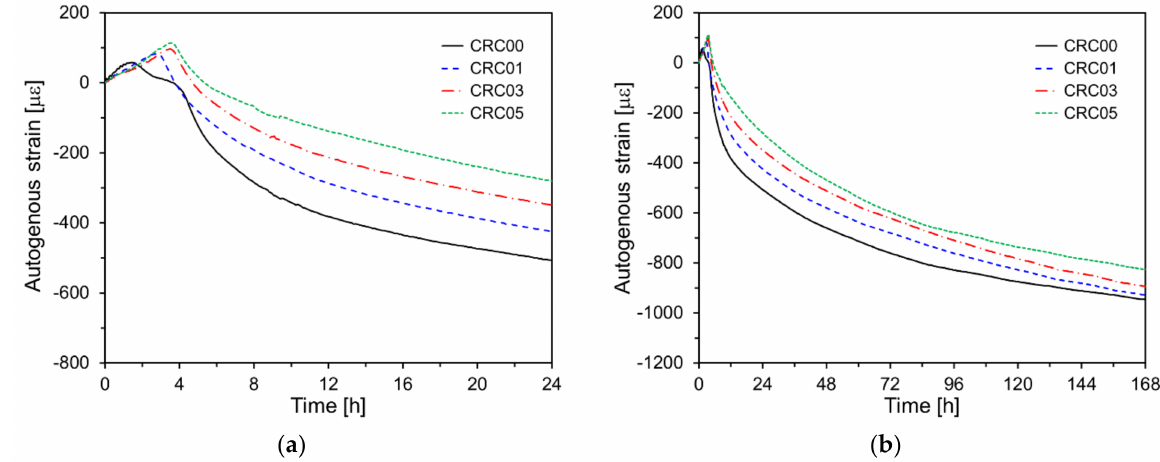
Figure 10. Autogenous shrinkage of CNT-reinforced cement composites: ( a ) 24 h; ( b ) 168